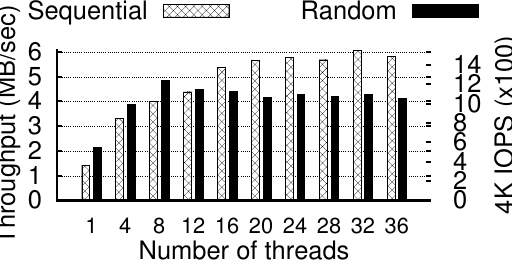
Figure 10. write() + fsync() with multi-thread, I/O on internal eMMC. Filesize: 512 MB; I/O-size: 4 KB [Samsung Galaxy S4, Android 4.2.2 (JB), /data partition, EXT4].